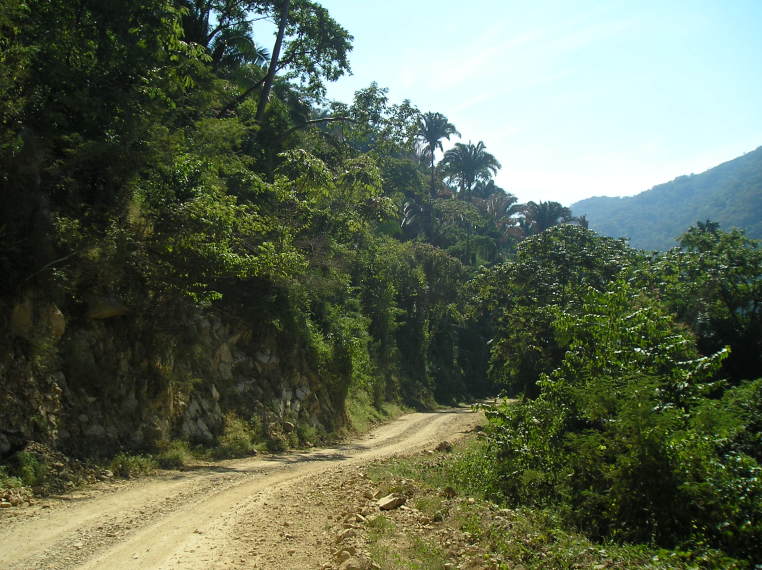
Brachypelma
hamorii habitat, subtropical dry forest, near Manzanillo, Colima state, Mexico. Photo: Stuart J. Longhorn.